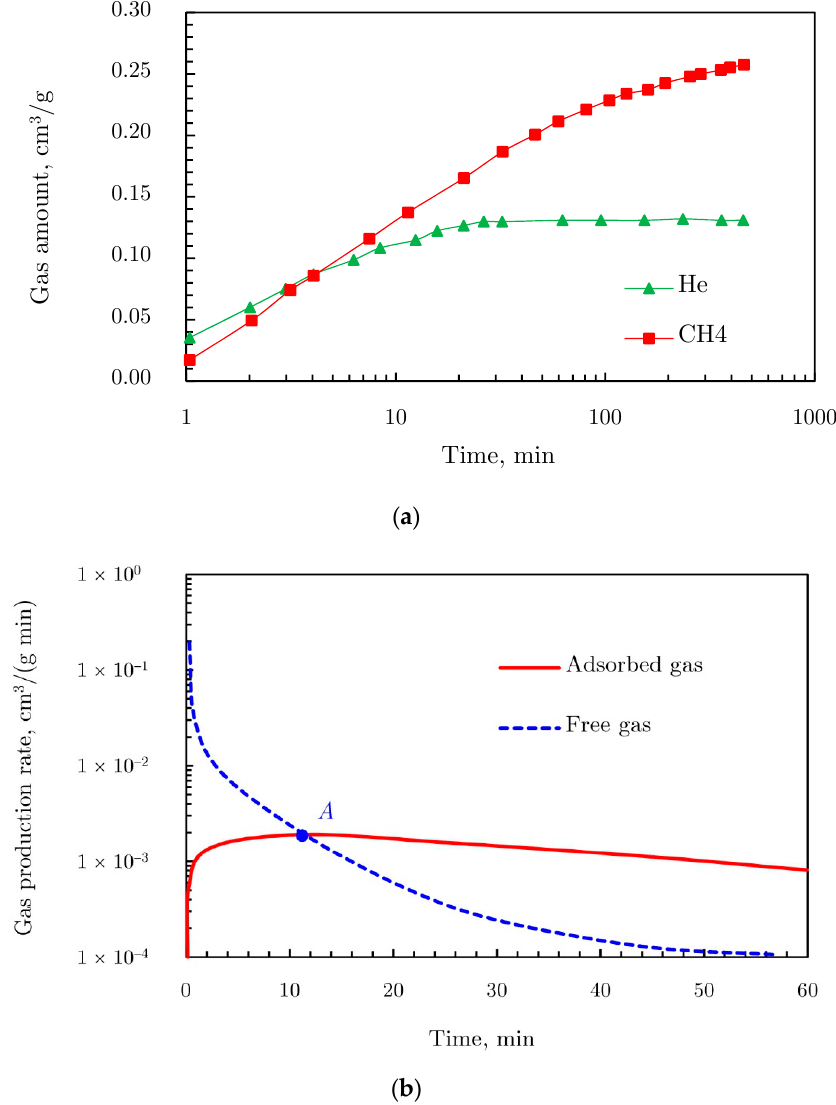
Figure 19. Experimental data ( a ) and mathematical simulation results ( b ) for gas transport process at 3.4 MPa and 308 K [60].